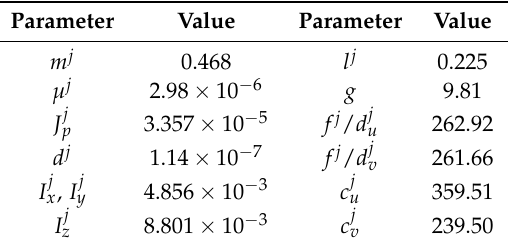
Table 2. Quadcopter and camera